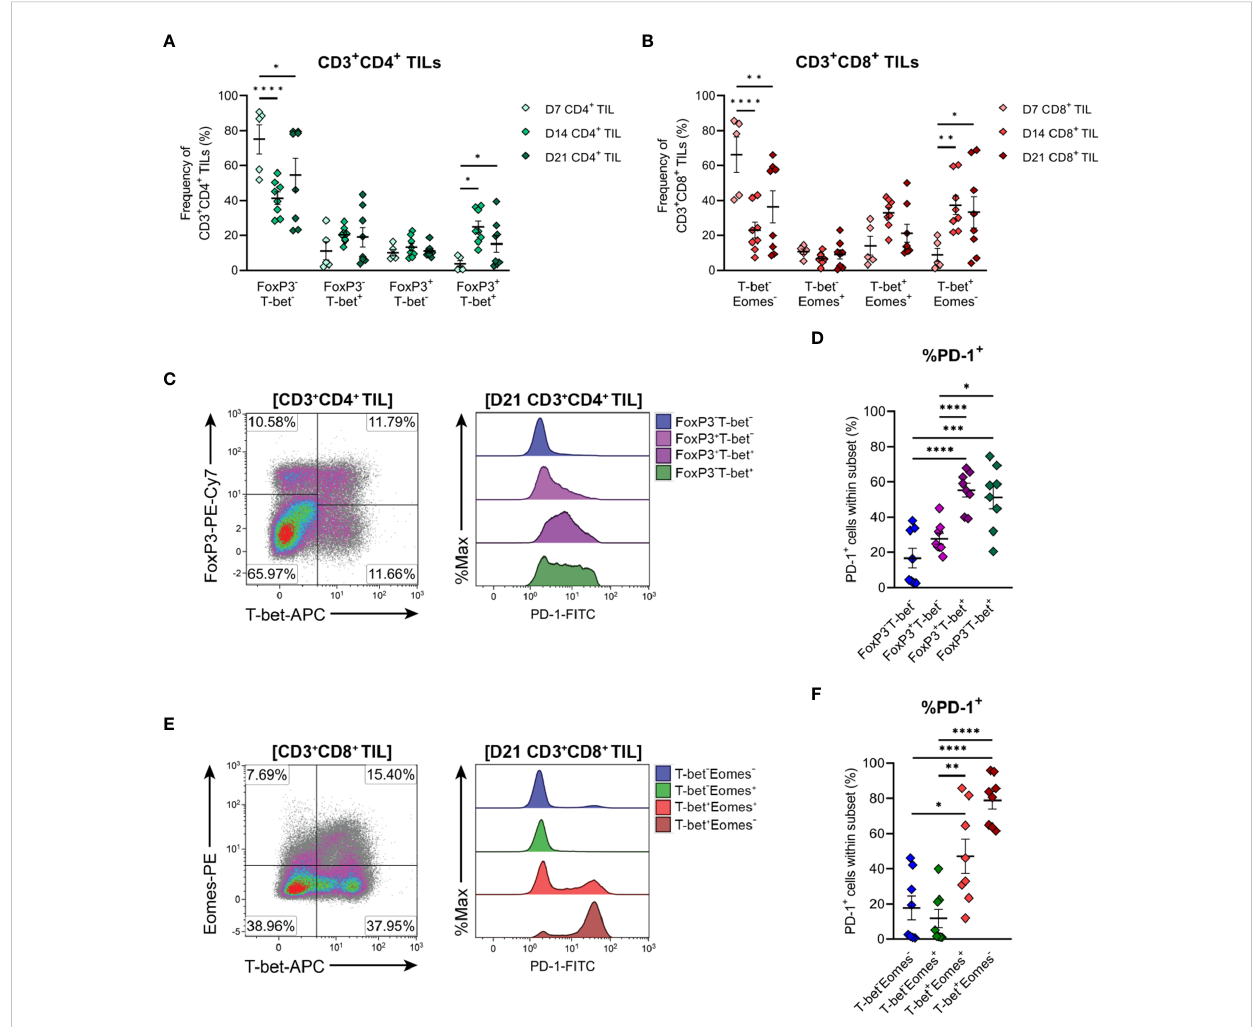
FIGURE 7 Differentiation status of CD4 + and CD8 + T cells in fi ltrating MC38 tumours. (A) Frequencies of T-bet and FoxP3 subsets within total CD3 + CD4 + TIL. (B) Frequencies of T-bet and Eomes subsets within total CD3 + CD8 + TIL. (C) Representative fl ow plots depicting the distribution of T-bet and FoxP3 subsets and their expression of PD-1 in CD3 + CD4 + TIL isolated from D21 MC38 tumours. (D) Expression of PD-1 (%PD-1 + ) within FoxP3 and T-bet subpopulations of D21 CD3 + CD4 + TIL. (E) Representative fl ow plots depicting the distribution of T-bet and Eomes subsets and their expression of PD-1 in CD3 + CD8 + TIL isolated from D21 MC38 tumours. (F) Expression of PD-1 (%PD-1 + ) within T-bet and Eomes subpopulations of D21 CD3 + CD8 + TIL. All density plot percentages indicate frequencies as the proportion of the gated population (indicated in bold titles with square brackets). All data are representative of 8-10 biological replicates per timepoint. Graphs represent the mean and standard error of the mean (SEM, error bars). Statistical analyses were performed using two-way (A, B) or one-way (D, F) ANOVA with post-hoc Tukey test to correct for multiple comparisons. *p ≤ 0.05; **p ≤ 0.01; ***p ≤ 0.001; ****p ≤